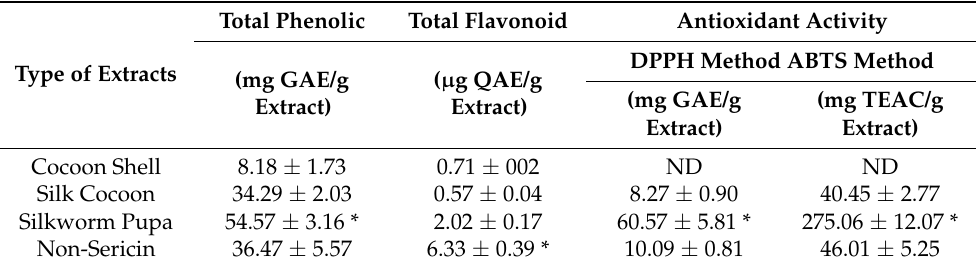
Table 1. The antioxidant activity, total phenolic and flavonoid contents of silk cocoon extracts accessed by DPPH and ABTS methods.